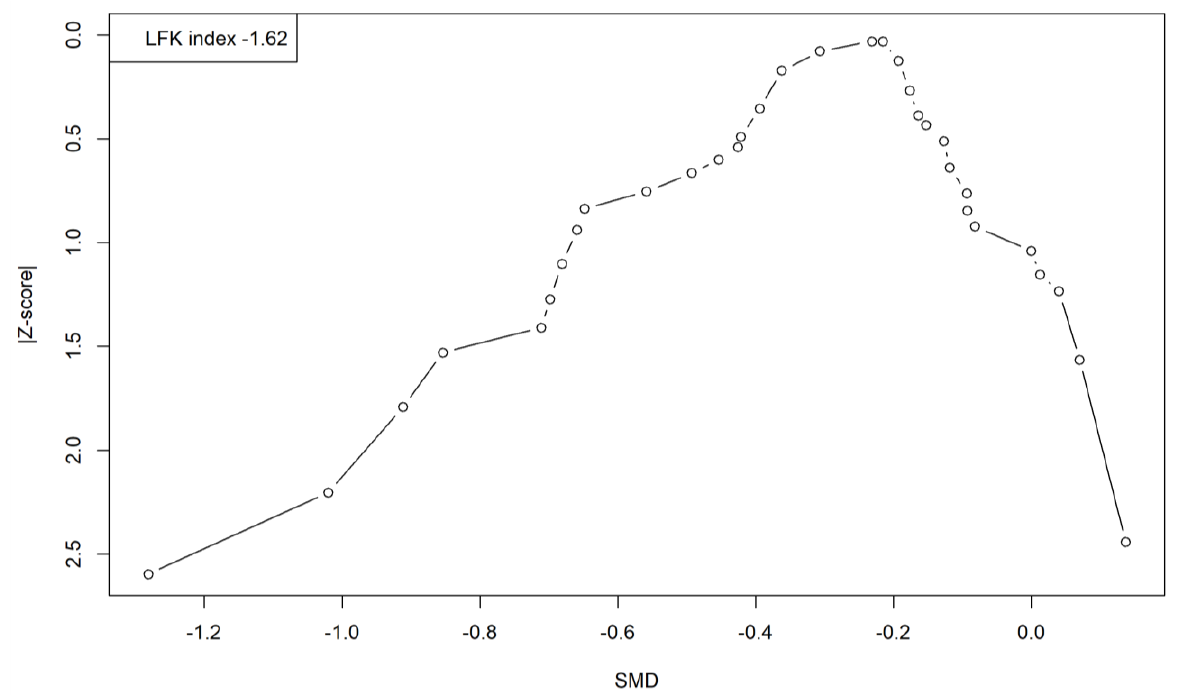
Figure A7. Doi plot and LFK index of the studies included in the sensitivity analysis.